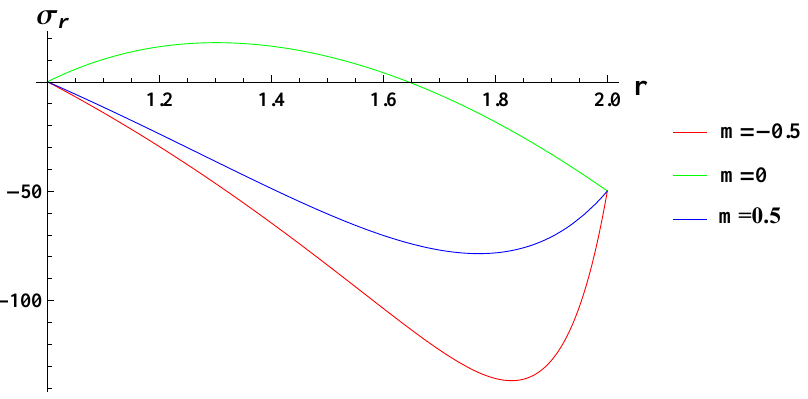
Figure 25. Radial stress (in MPa) along the radius r (in cm) of the cylinder, under the effect of rotation ( ω 2 = 50 rad/s), external pressure p o = 50 MPa and quadratic volume reinforcement. Tangential stress in a rotating cylinder under external pressure is depicted in Figure 26.